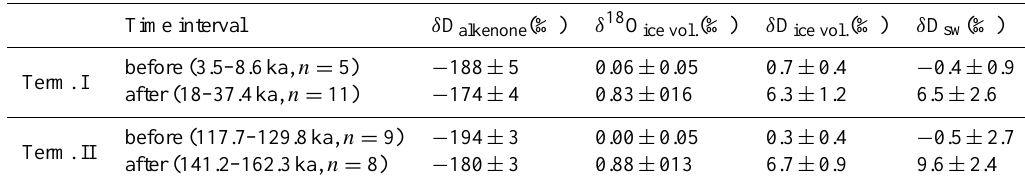
Table 3. Average values for the hydrogen isotope composition of the C 37 : 2 − 3 alkenones, the global δ 18 O ice vol. (Waelbroeck et al., 2002), δ D ice vol. (Srivastava et al., 2010) and the local δ D sw derived from δ 18 O of G. bulloides (Martinez-Mendez et al., 2010) for the intervals of before and after Termination I and II.